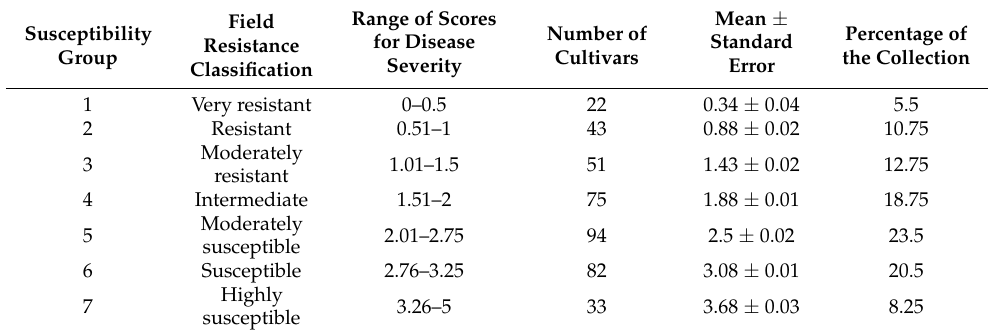
Table 1. Levels of field resistance to European canker among 400 Asturian apple accessions after phenotypic observations in 14-year-old apple trees exposed to natural infections in Oles (north- western Spain). The range of scores for disease severity, number of cultivars and percentage of the germplasm collection comprised in each level of field resistance. Means ± standard errors within each group are also